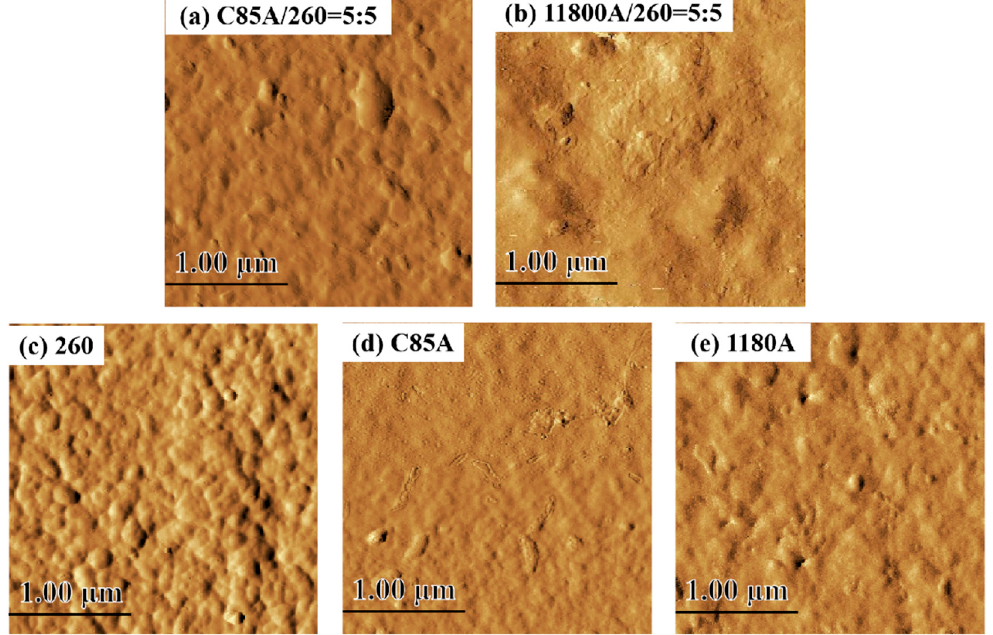
Figure 6. AFM phase images comparing the phase area size change of TPU blends at 50% ratio ( a ) ESC85A/ES260 = 5:5, ( b ) ET1180A/ES260 = 5:5 and neat TPU ( c ) ES260, ( d ) ESC85A, ( e ) ET1180A. The smaller swollen particles in (a) indicate that they have a larger phase domain size. All scanning areas were 2.5 × 2.5 µ m 2 with 29.469 nm roughness (Rq).